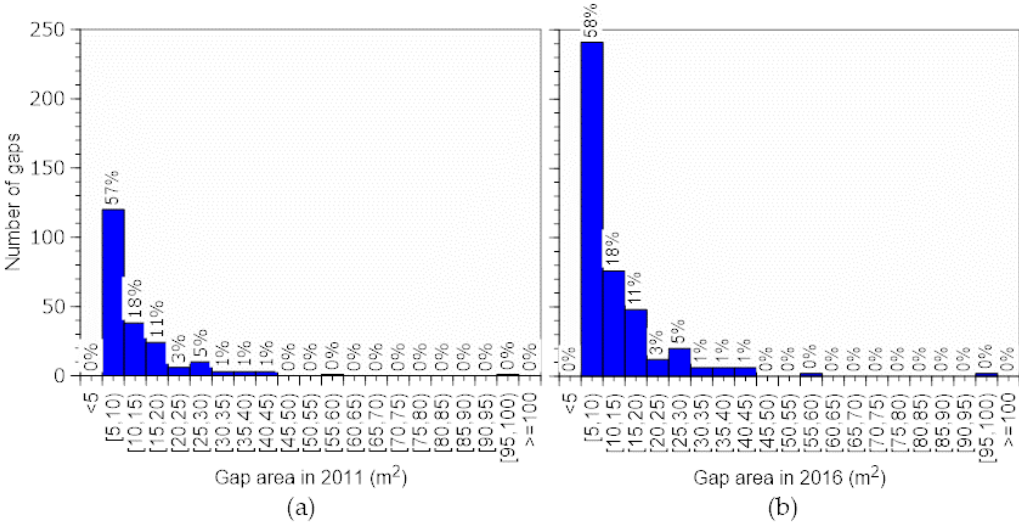
Figure 6. Number of gaps. New gaps by area class ( a ) between 2005 and 2011 (period A) and ( b ) between 2011 and 2016 (period B).